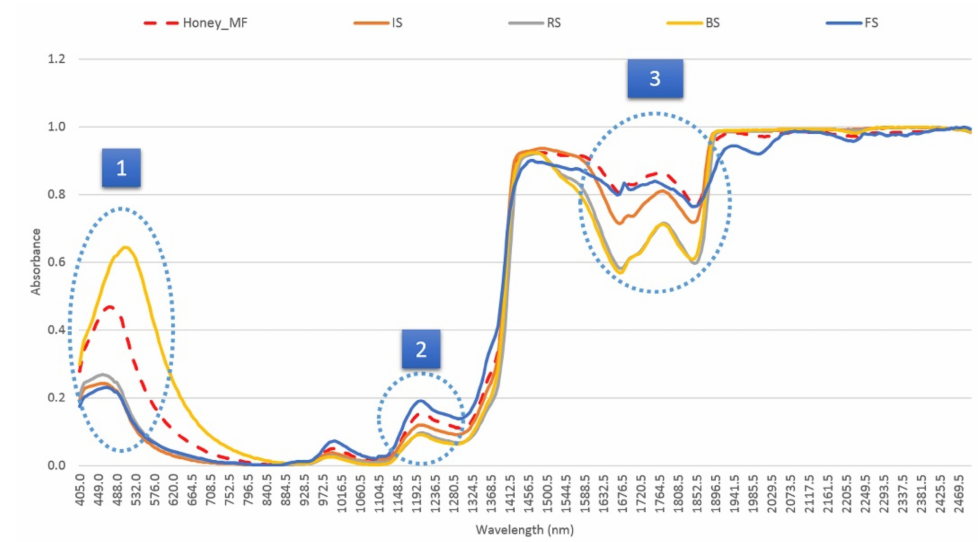
Figure 3. Average Vis-NIR spectra for pure multi-floral honey and for the four different sweeteners used for the adulteration (rice syrup (RS), invert sugar (IS), brown cane sugar (BS) and fructose syrup (FS)), in the regions 1, 2 and 3 the honey samples show different intensities depending on the type of adulterant. Reprinted with permission from ref. [50]. Copyright 2019 Copyright Elsevier